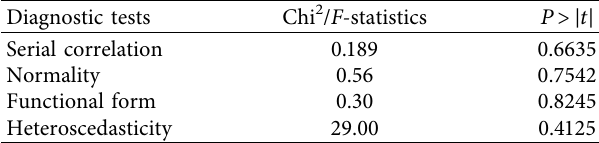
Table 6: Diagnostic test of the ARDL